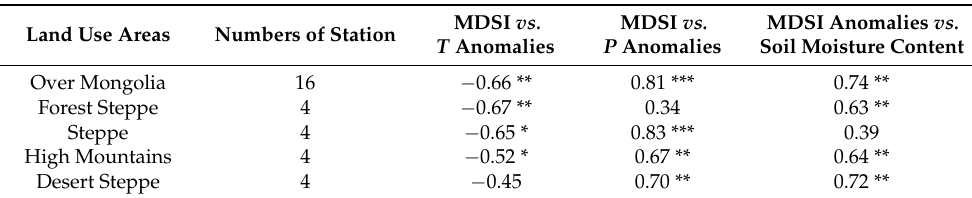
Table 5. Correlations among the MDSI anomaly with different climatological variables over all of Mongolia during the growing season of 2000–2013.